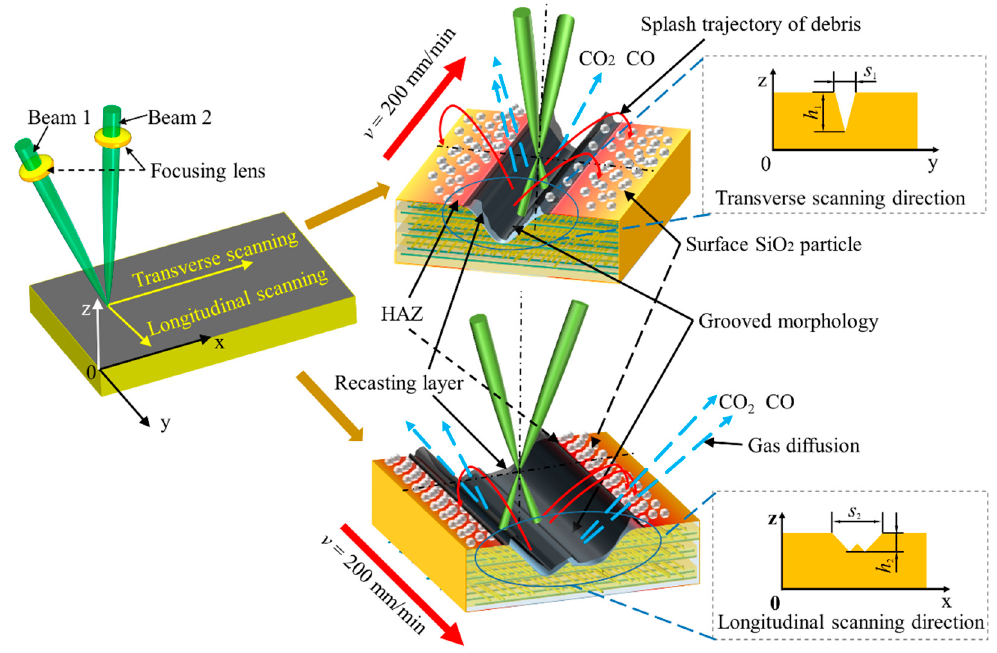
Figure 19. Schematic diagram of CMC-SiC f /SiC by using dual-beam coupling nanosecond laser.